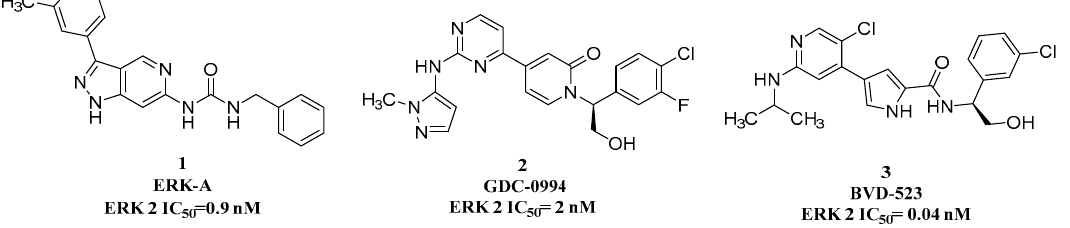
Figure 1. Structures of representative ERK inhibitors.